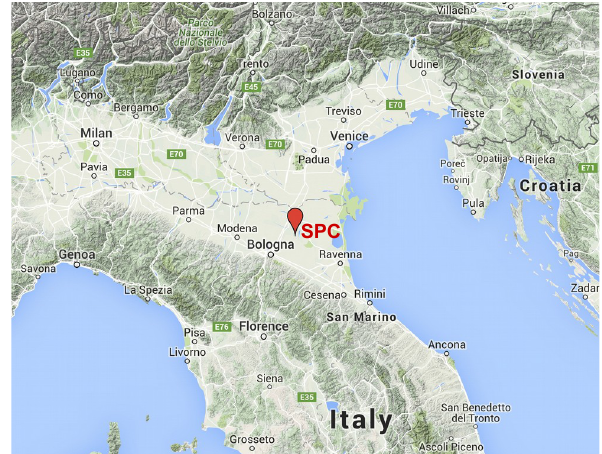
Figure 1. The map of northern Italy, where the location of the San Pietro Capofiume (SPC) measurement site is shown with a red marker. Map data were provided by